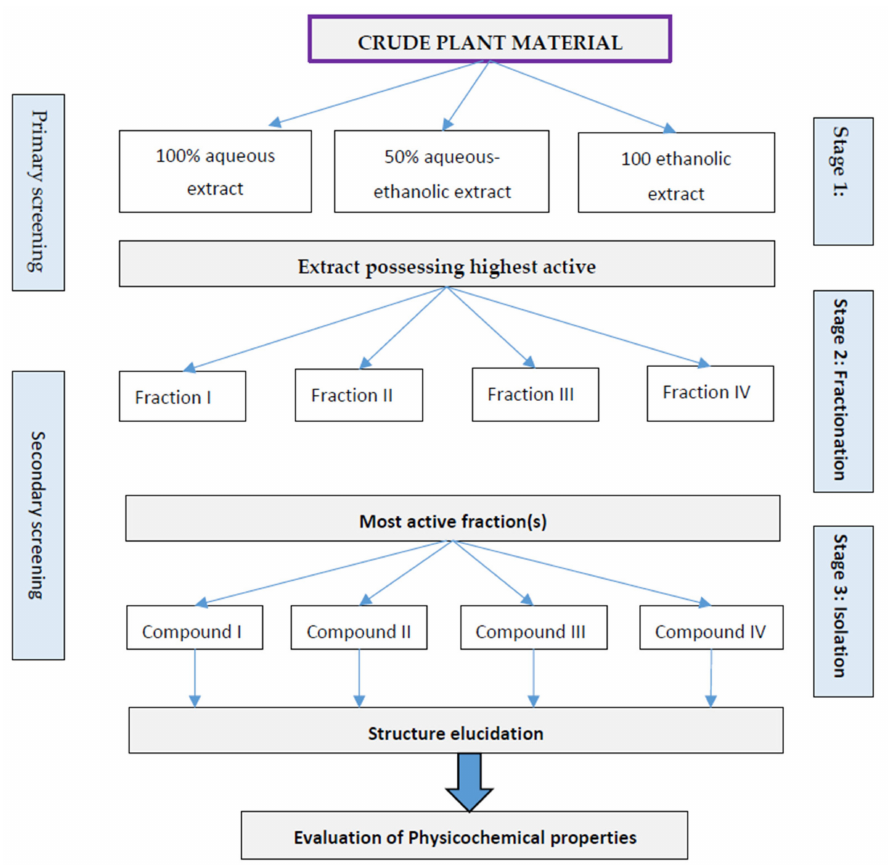
Figure 2. An outline of parallel approach for biological activity guided fractionation of plant